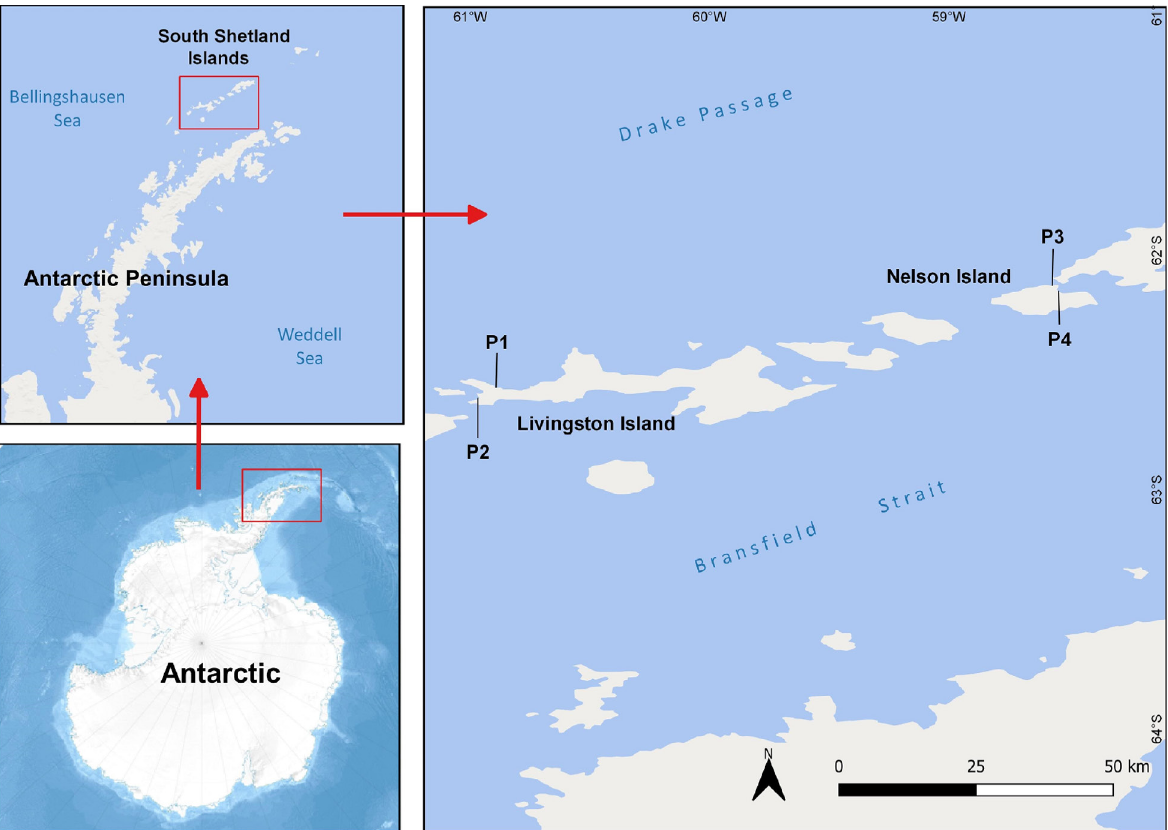
Figure 1. Location of soil sampling points (P1, P2, P3 and P4) with the influence of different species of seabirds in the Livingston and Nelson Islands,